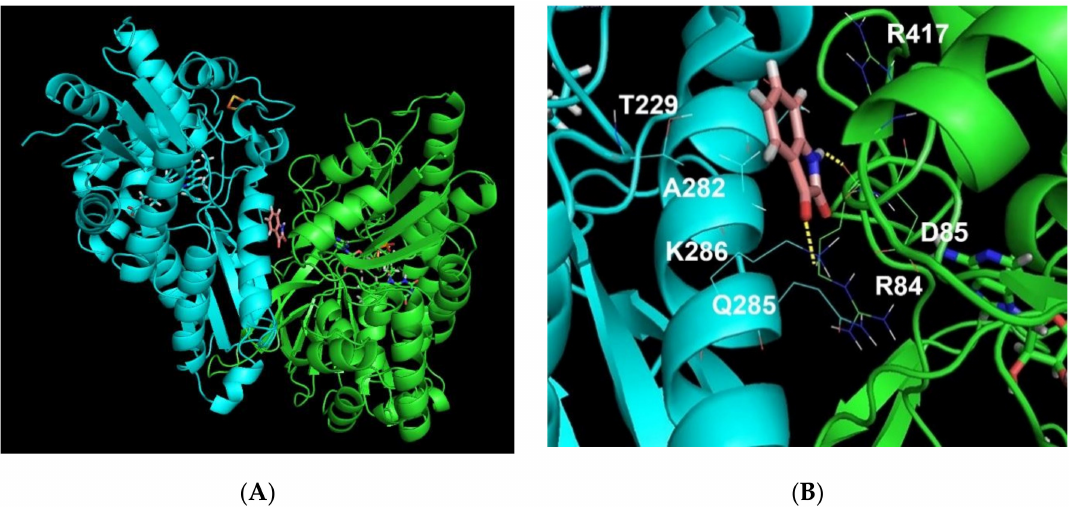
Figure 5. The model of a complex of FECH (cyan) and ADR (green) with isatin ( A ). Predicted isatin binding site in the FECH / ADR complex ( B ). Hydrogen bonds between isatin and amino acid residues of proteins are shown by a yellow dotted line. The model of complex was designed using FECH (PDB ID 2qd1, chain B) and ADR (PDB ID 1cjc, chain